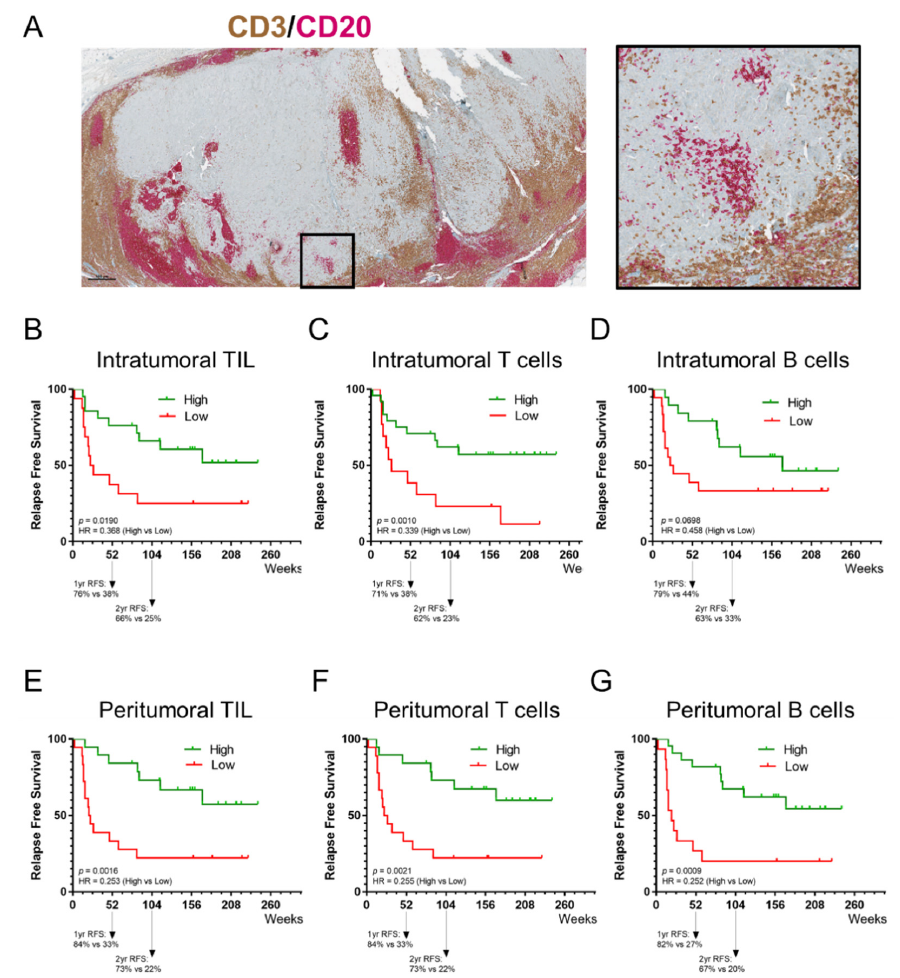
Figure 3. Prognostic value of tumor-infiltrating lymphocytes. ( A ) Representative image of a tissue section of a melanoma metastasis stained for CD3 and CD20; shown here are an overview of the section and a region of interest. IHC slides were scanned at ×40 magnification and the images are displayed at ×2.2 (Scale bar = 500 μ m) and ×10 magnification. ( B – D ) Kaplan–Meier estimates of RFS